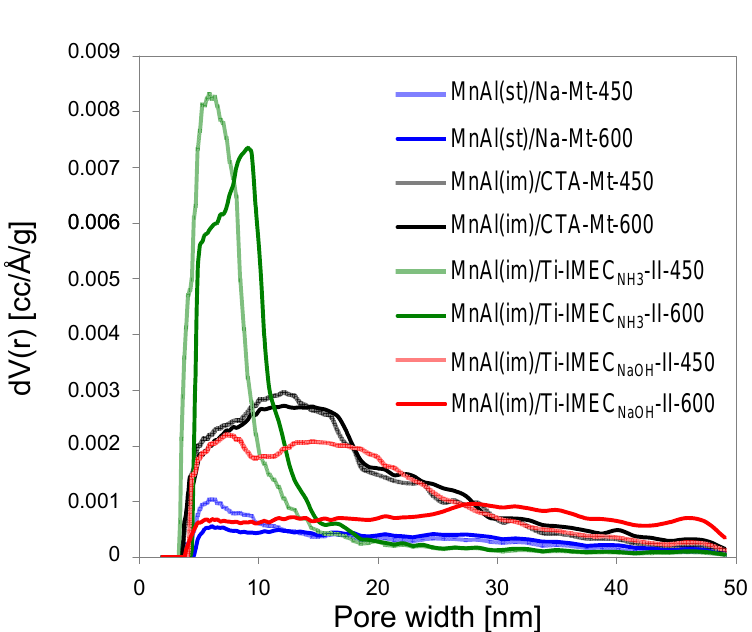
Figure 3. Pore size distribution profiles of investigated composites calcined at 450 and 600 °C.